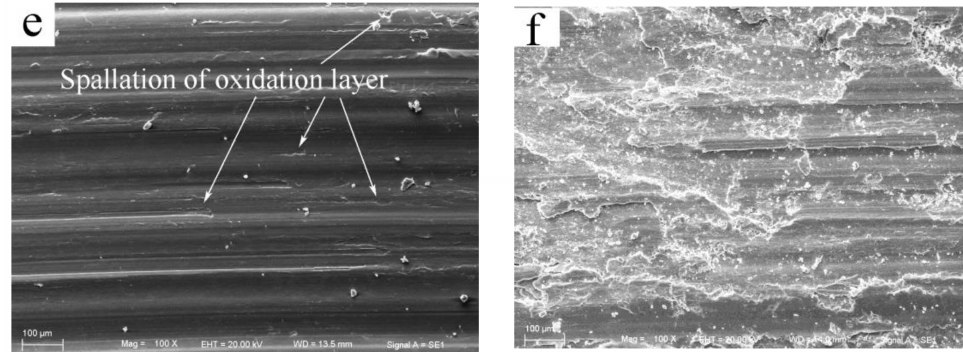
Figure 5. SEM morphologies of worn surfaces of Mg97Zn1Y2 alloy at 0.8 m/s and different applied loads: ( a ) 20 N, ( b ) 60 N, ( c ) 140 N, ( d ) 260 N, ( e ) 260 N, ( f ) 380